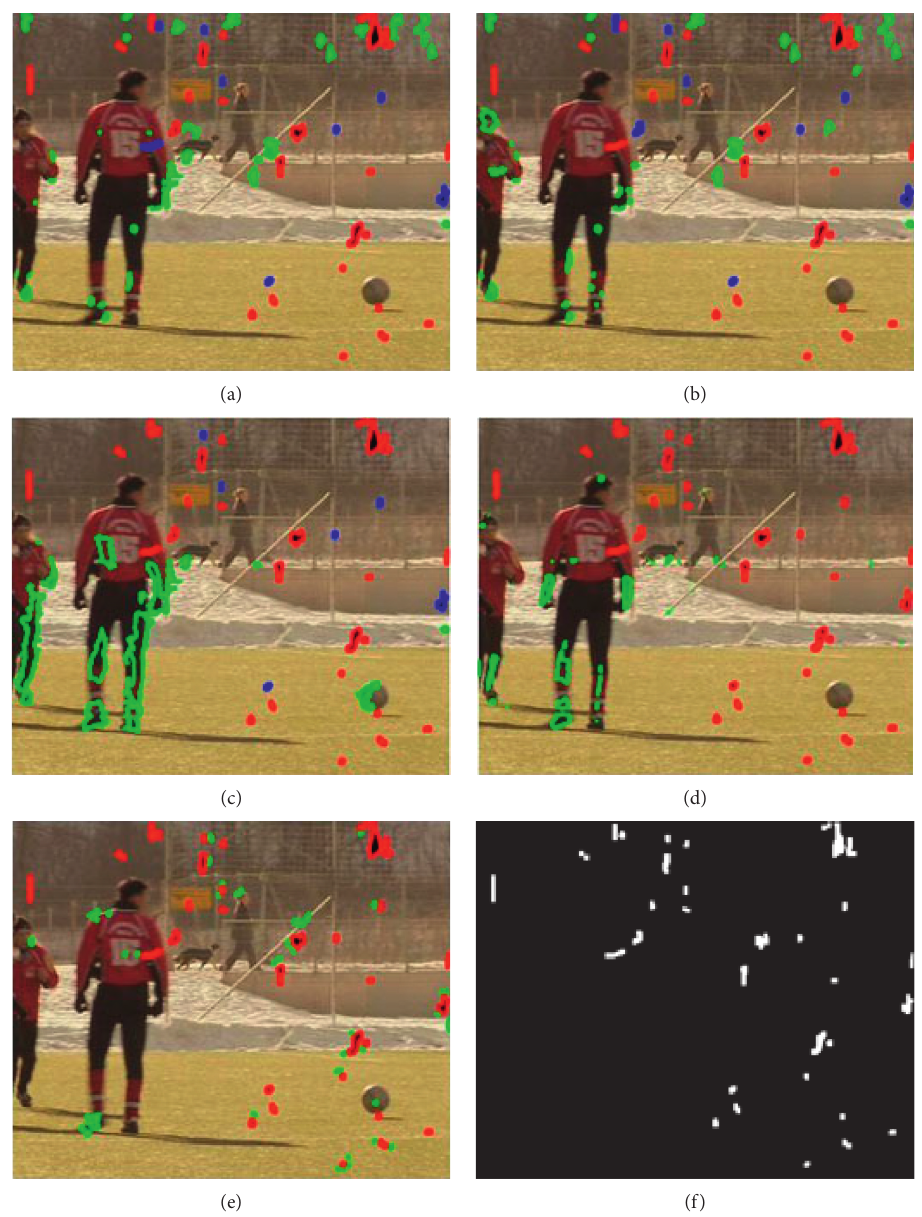
Figure 12: Results of black coloured artificial blotch detection studies for “football_1” dataset: (a) the HOG feature, (b) the LBP feature, (c) the region matching, (d) the SDI, (e) the proposed method, and (f) the mask showing blotch